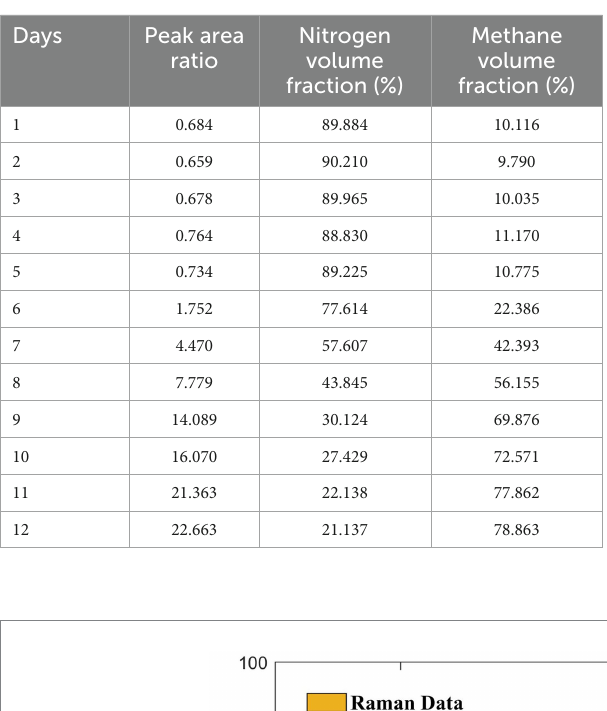
TABLE 2 Volume fraction of methane and nitrogen calculated from the curve.